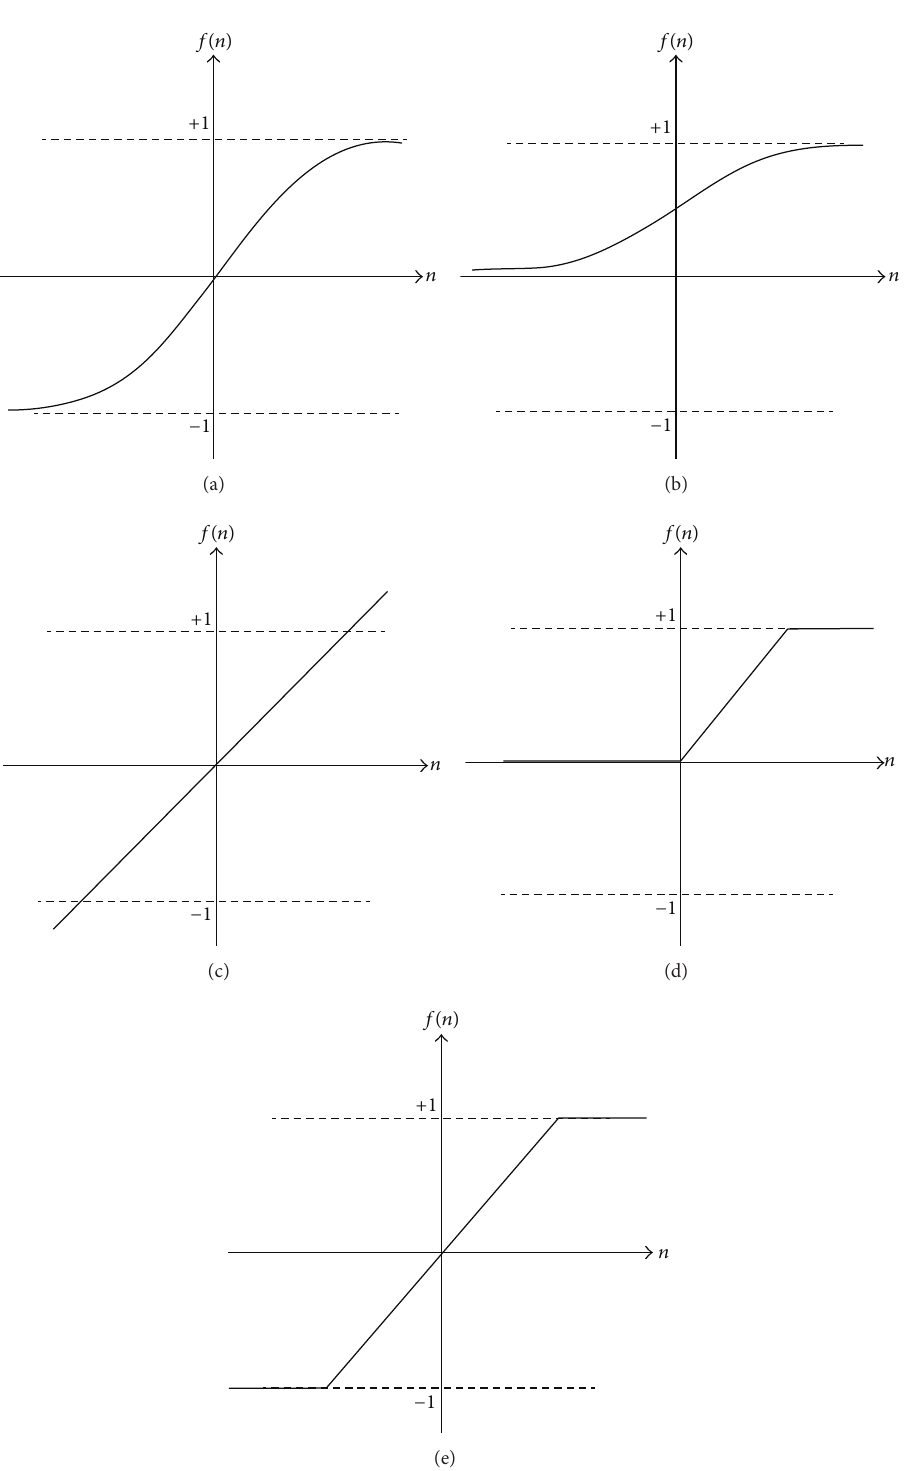
Figure 1: Transfer functions: (a) hyperbolic tangent sigmoid, (b) logarithm sigmoid, (c) linear, (d) saturating linear, and (e) symmetric saturating